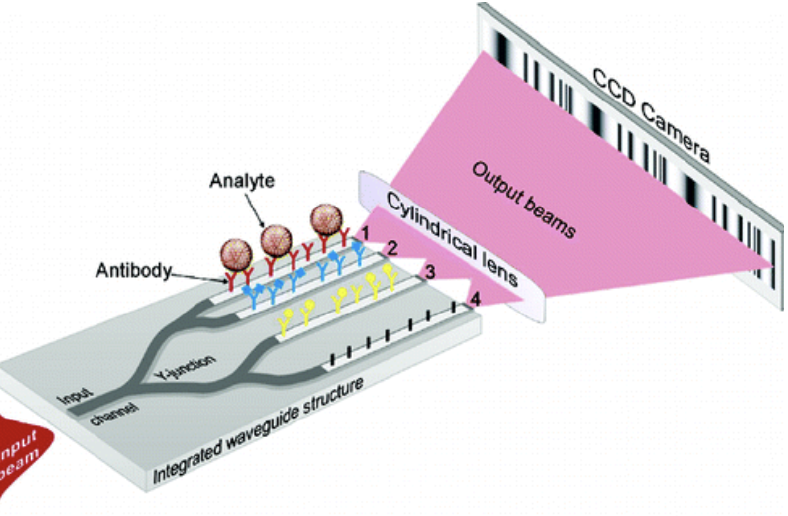
Figure 24. Integrated Young Interferometer with microfluidic approach. Laser light is coupled into the double sample and reference waveguides and phase change due to adsorption is detected through signal integration. Reprinted with permission from [147]. Copyright © (2007) American Chemical